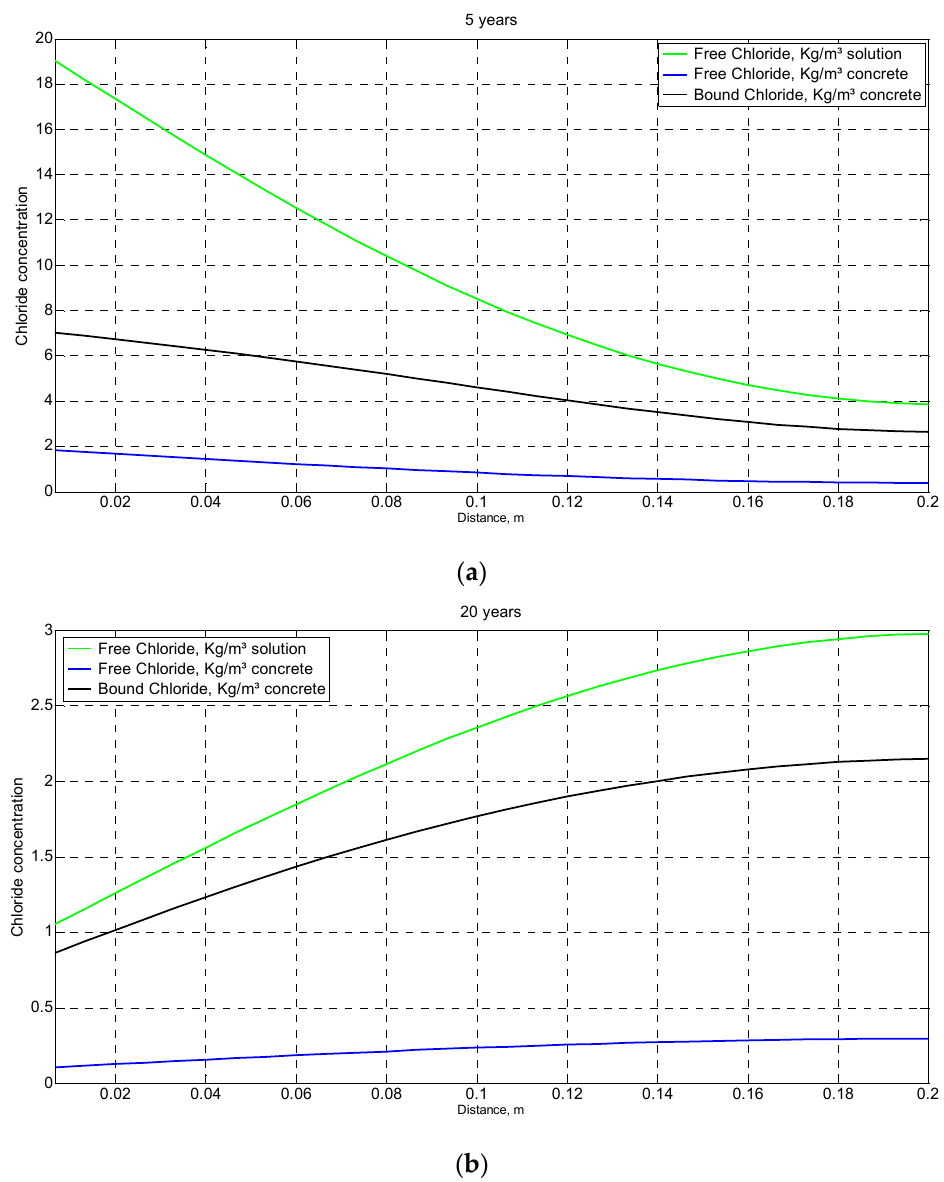
Figure 17. Concentration profiles of C f,s (free chloride in kg/m 3 solution), C f,c (free chloride in kg/m 3 concrete) and C b (bound chloride in kg/m 3 solution), at ( a ) 5 and ( b ) 20 years.